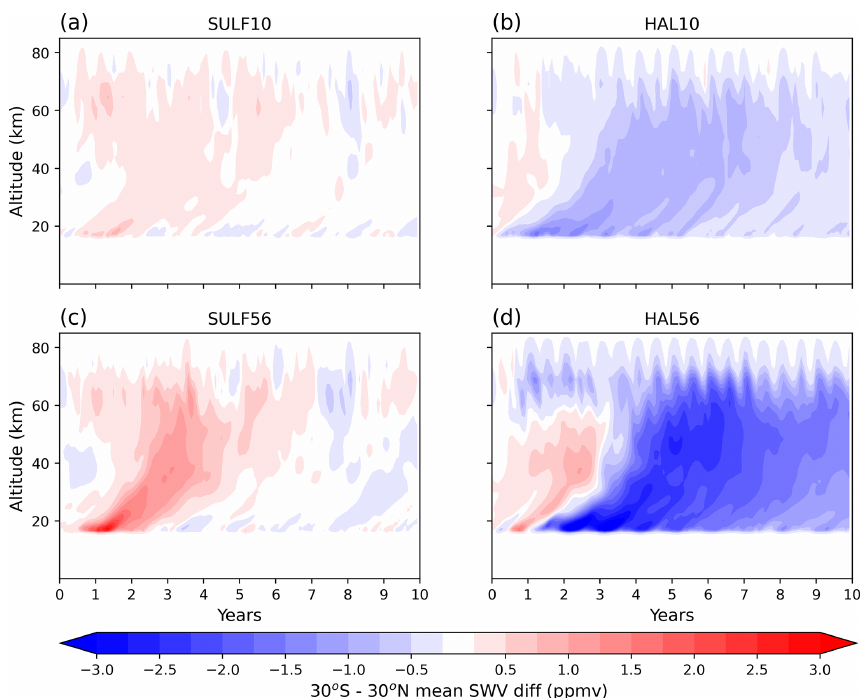
Figure 7. The 30 ◦ S–30 ◦ N mean stratospheric water vapour anomalies (ppmv) relative to the control climatology as a function of altitude and time: (a) SULF10, (b) HAL10, (c) SULF56, and (d) HAL56. Red colours indicate SWV enhancement, and blue colours indicate column SWV